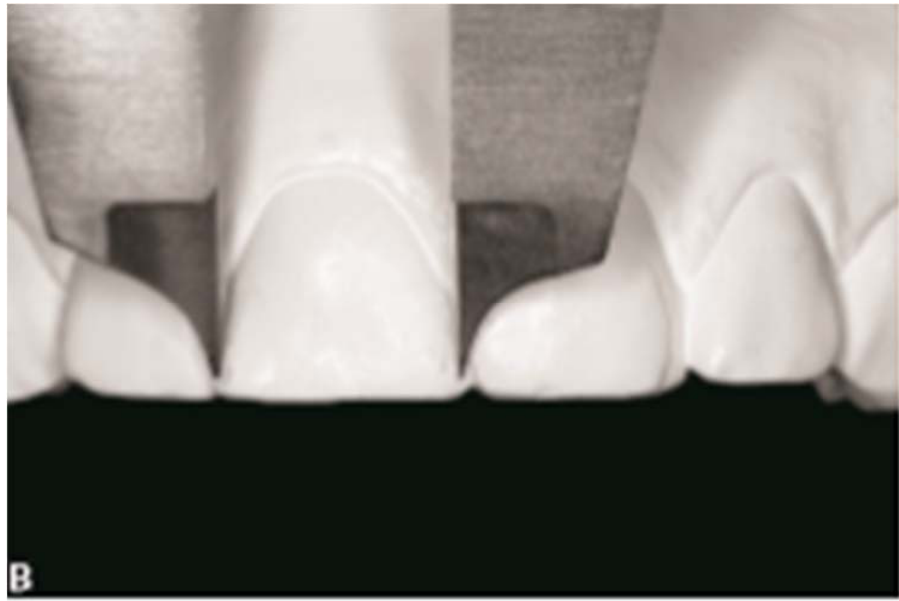
Figure 2. Dental casts evaluation.